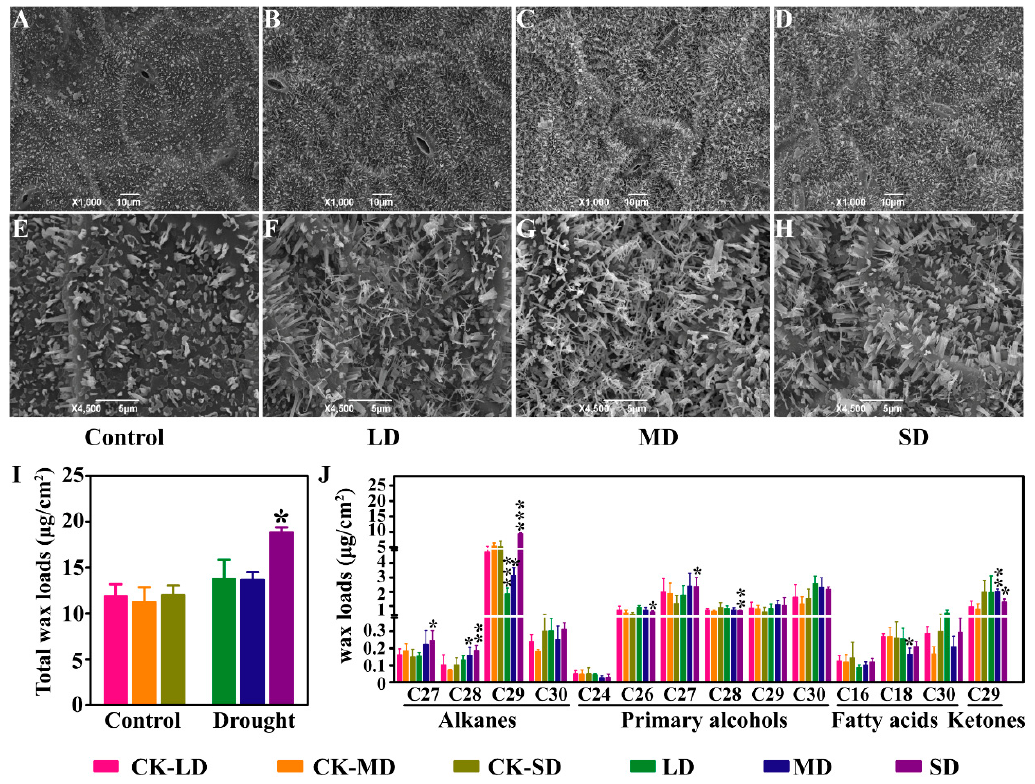
Figure 2. Morphology observation and determination of epidermal wax content and composition under varying degrees of drought stress. ( A – H ) Scanning electron microscope observation of epidermal wax morphology under varying degrees of drought stress at the magnifications of 1000 × g ( A – D ) and 4500 × g ( E – H ). ( I ) Determination of total wax content under varying degrees of drought stress. ( J ) Quantitative analysis of wax components by GC-MS. The data are the means ± SD ( n = 4). LD, mild drought stress; MD, moderate drought stress; SD, severe drought stress; CK-LD, CK-MD, and CK-SD, the respective controls of LD, MD, and SD. Statistical significance was determined by Student’s t -test. * p < 0.05, ** p < 0.01, *** p < 0.001.